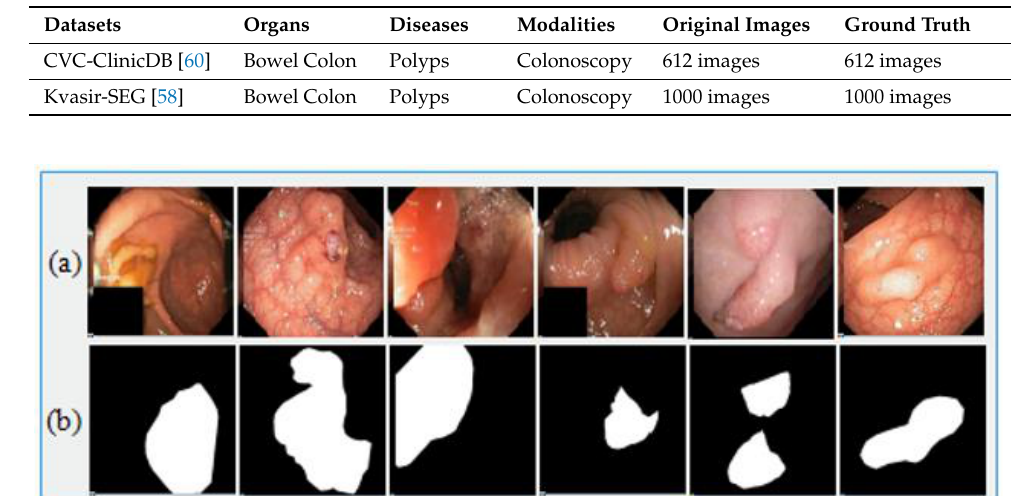
Figure 5. Sample Kvasir-SEG dataset images. ( a ) Original images and ( b ) ground truth